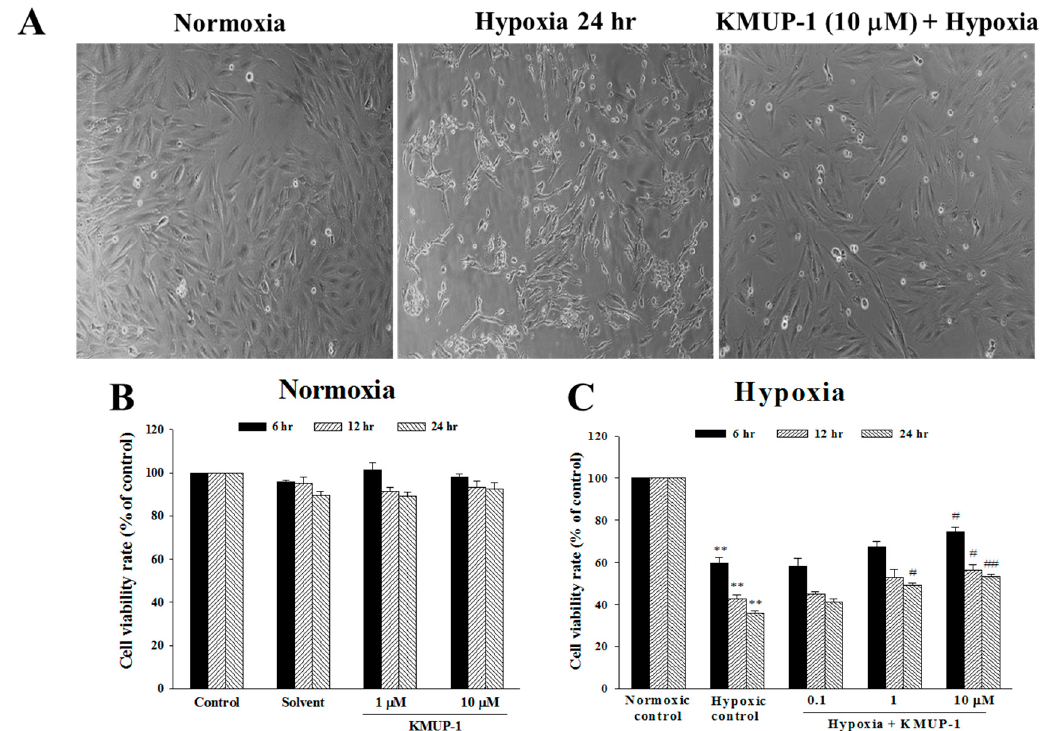
Figure 2. Effect of hypoxia on H9c2 cell viability. Cells were cultured in normoxia or hypoxia for 24 h. ( A ) Phase-contrast photomicrographs; normoxia, hypoxia, and KMUP-1 (10 μ M) pretreatment. The cell viability rate of H9c2 cell under ( B ) normoxic condition, and ( C ) hypoxic condition. The observation time was at 6, 12, and 24 h. All values were expressed as mean ± SEM (standard error of the mean), n = 3. ** p < 0.01 vs. normoxia, # p < 0.05 vs. hypoxia, ## p < 0.01 vs. hypoxia.